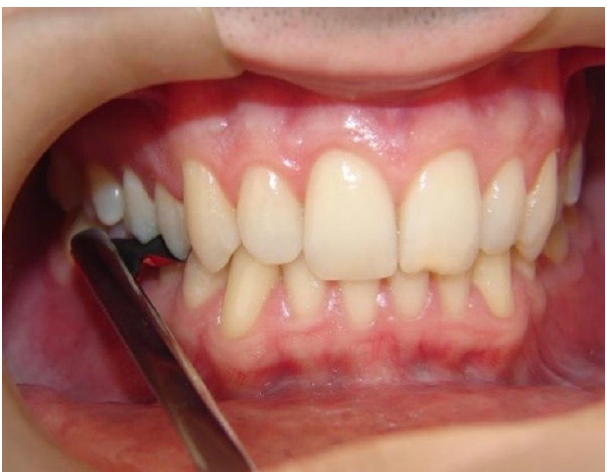
Figure 4. Evaluation of active tactile sensibility with carbon sheets in the premolar area of a partic- ipant (control group).